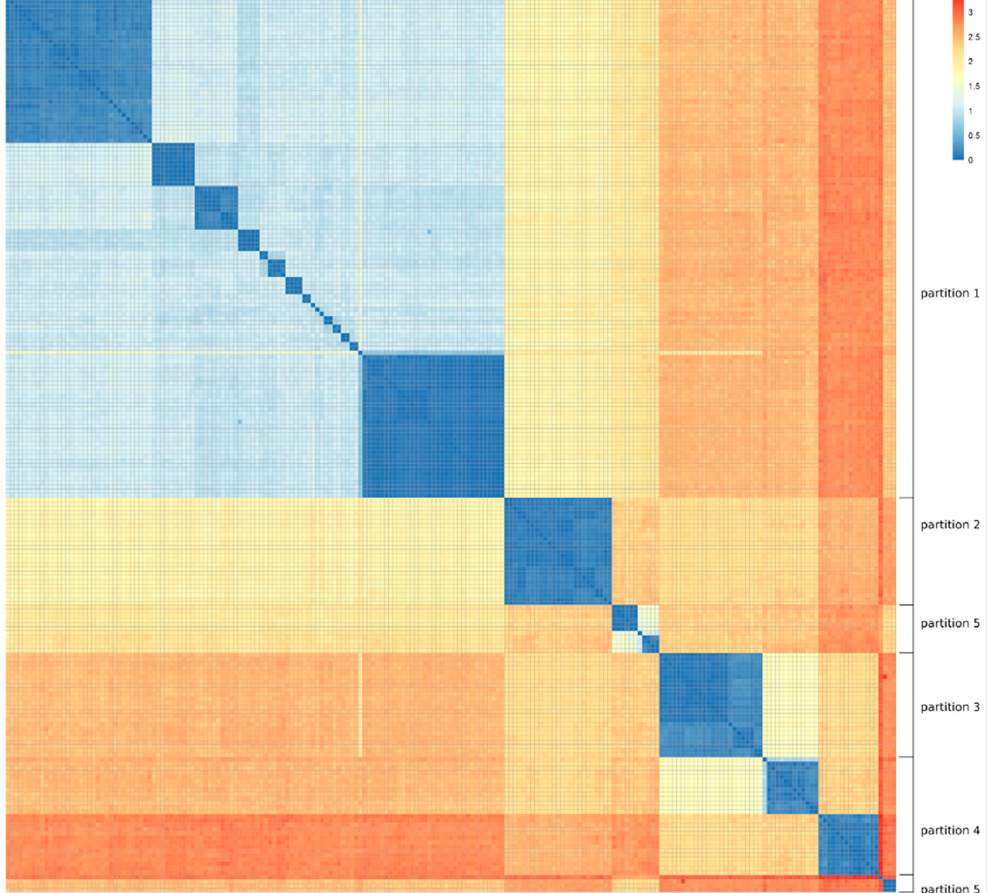
Figure 1. All-against-all matrix of the genetic distance between the 207 methicillin-resistant Staphylococcus aureus (MRSA) strains used for this study. Distance is calculated as 1-orthoANI and represented as color, where blue corresponds to lower and red corresponds to greater distance. The assignment of strains to partitions is marked on the right margin.